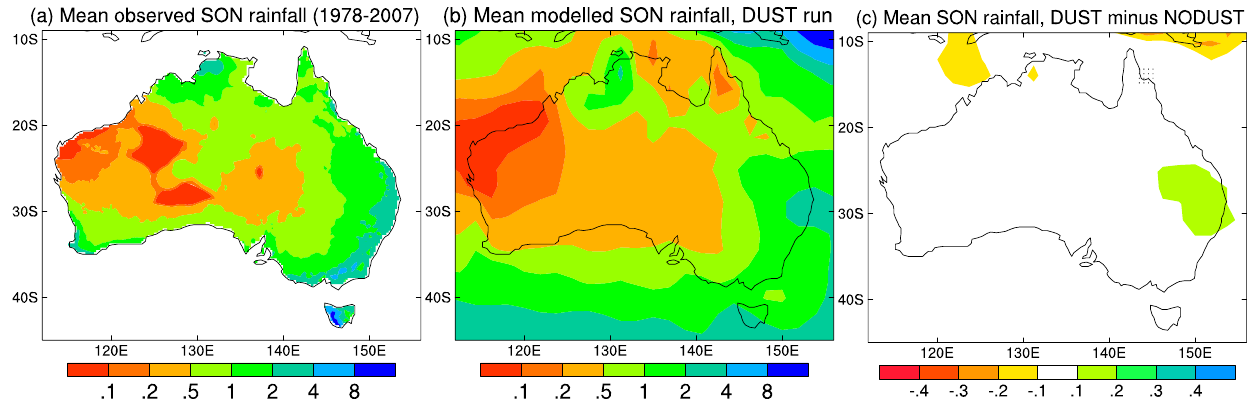
Fig. 4. Mean SON rainfall from (a) observations for 1978–2007, (b) the DUST run, and (c) the difference between the DUST and NODUST runs (in mm per day). In panel (c) , stippling shows the (single) grid box where differences are significant at